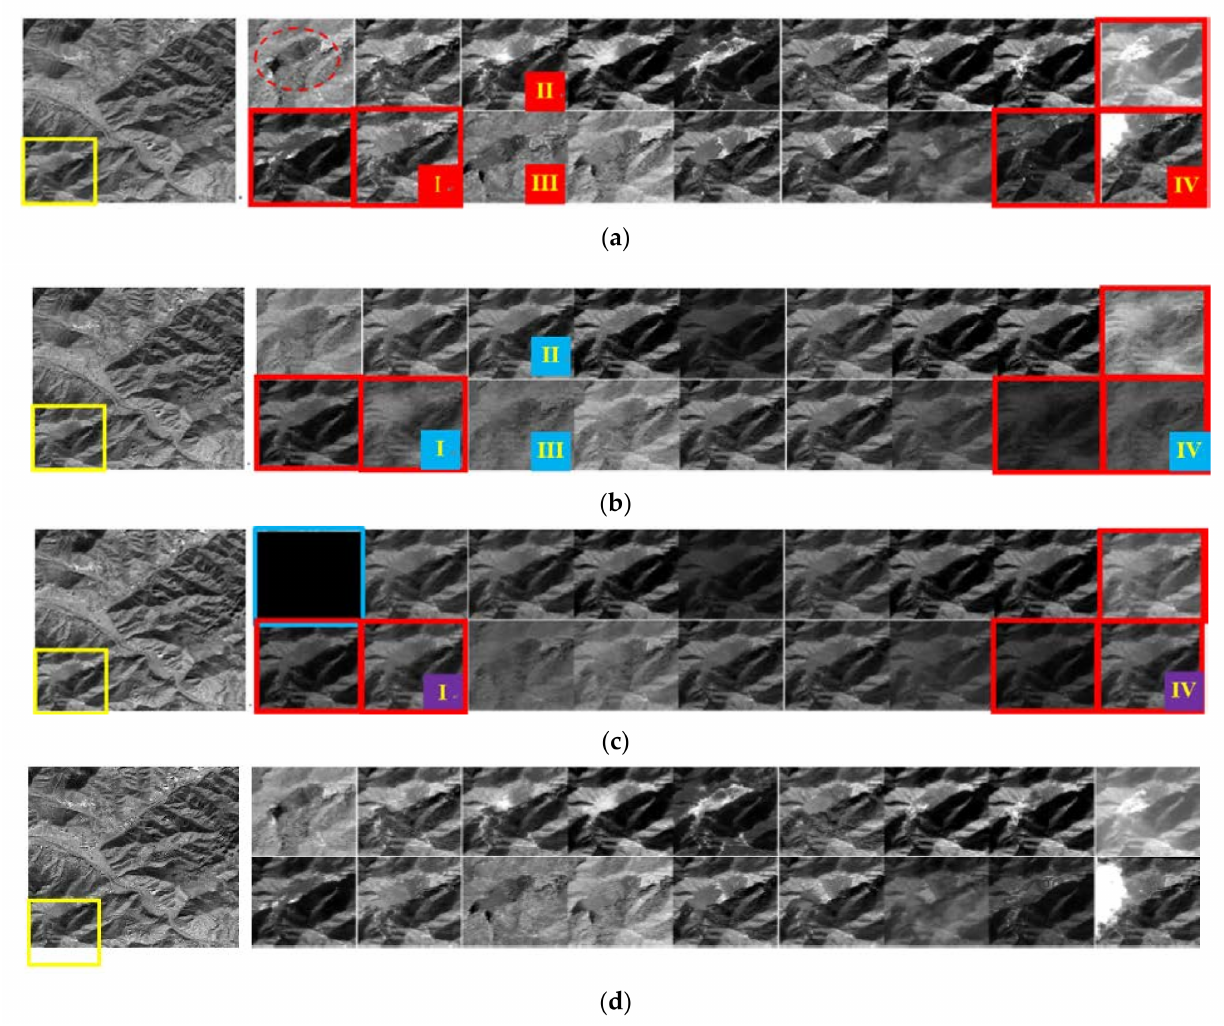
Figure 9. Global mean image (2850 × 3300 pixels) and local areas (950 × 1100 pixels) of the remote sensing image sequence and relevant results by LRC-BRE and CCFR in the mine production area. The leftmost images of ( a – d ) are the global mean images of the original image sequence, the stable feature image sequence restored by LRC-BRE, the stable feature image sequence restored by CCFR, and the image sequence registered by CCFR, respectively. The right images of ( a – d ) are the local areas of the above image sequence, whose spatial position corresponds to the yellow box of the left